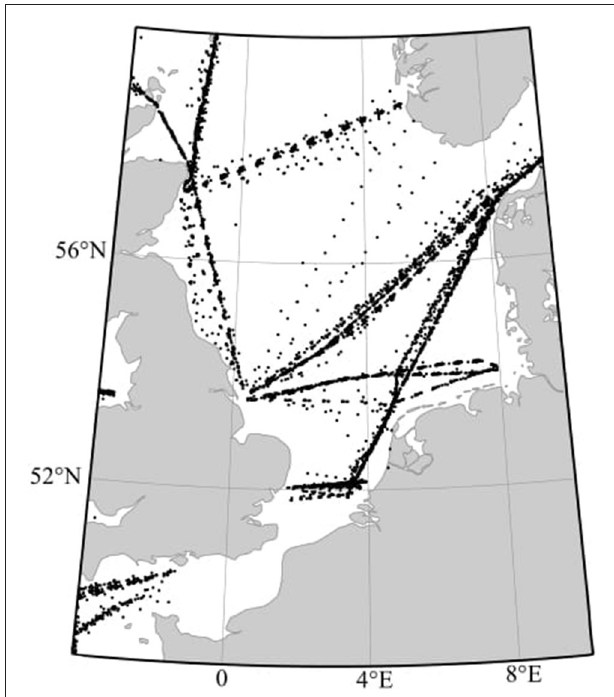
FIGURE 1 | Location of the 5977 CPR sample points from 1998 to 2010, in the areas of the North Sea and English Channel ( − 4 ◦ W to 9 ◦ E and 48 to 60 ◦